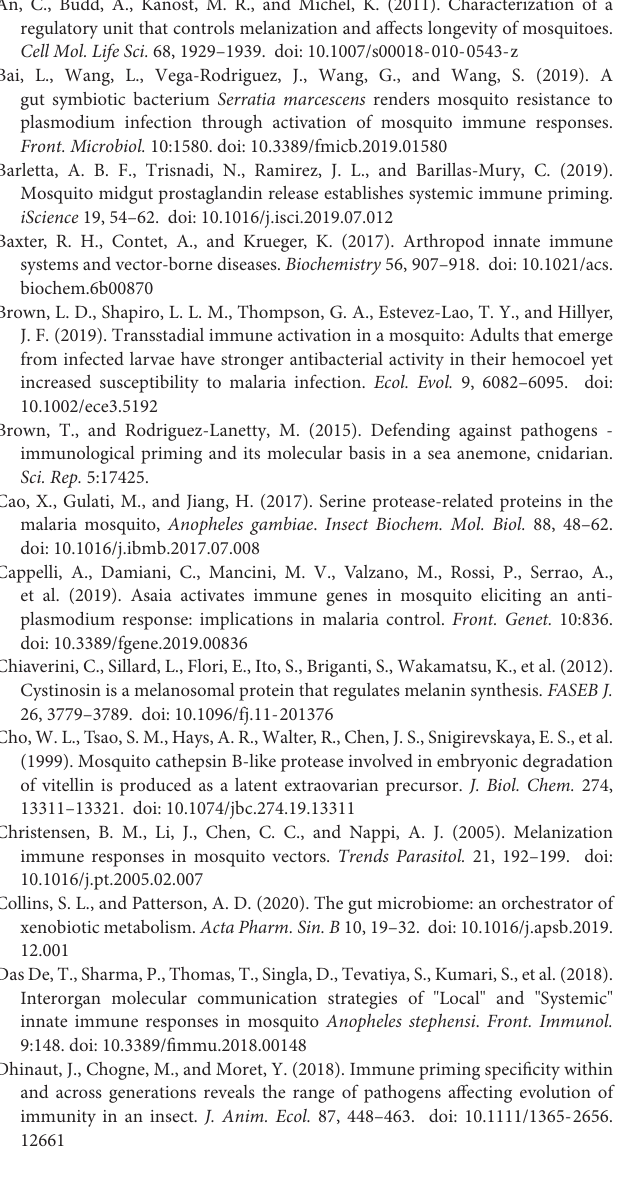
Dong, Y., and Dimopoulos, G. (2009). Anopheles fibrinogen-related proteins provide expanded pattern recognition capacity against bacteria and